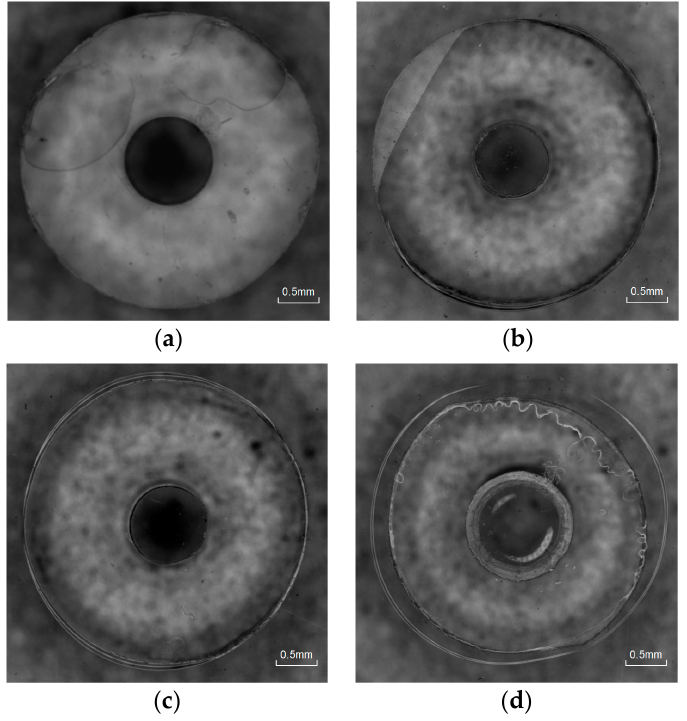
Figure 10. Interfacial Fusion at change rate of ( a ) 130%, ( b ) 100%, ( c ) 60%, and ( d ) 10%.